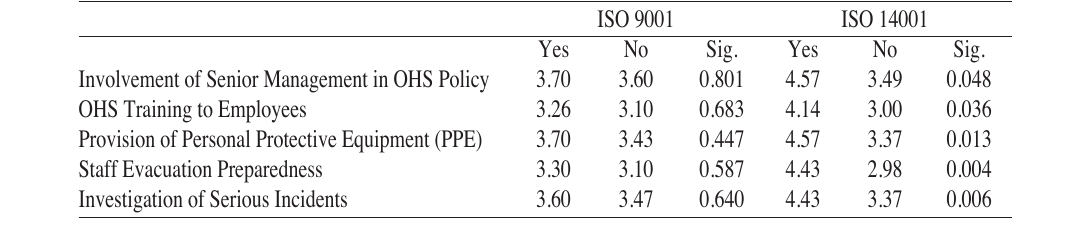
Table 9: Mean Comparison and ANOVA